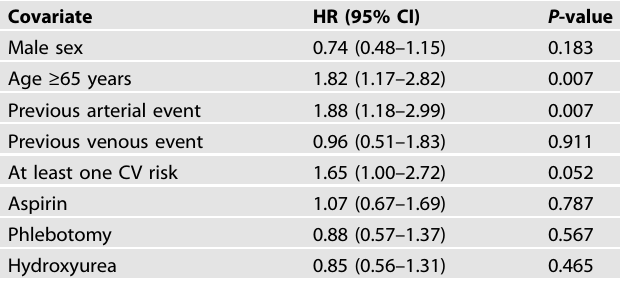
Table 4. Multivariable Cox proportional hazards model for the prediction of arterial thrombosis.